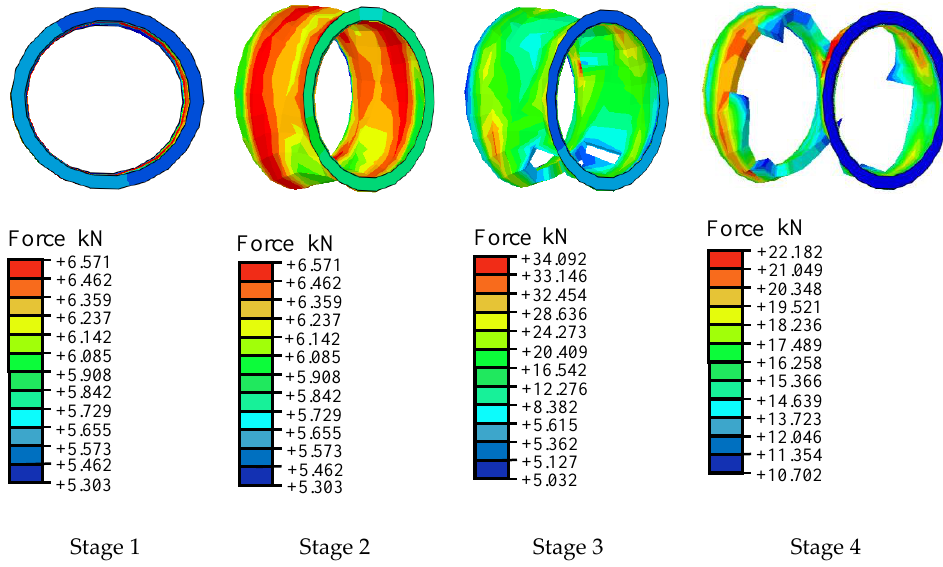
Figure 13. Stress distribution and evolution of the wellbore shear surface.